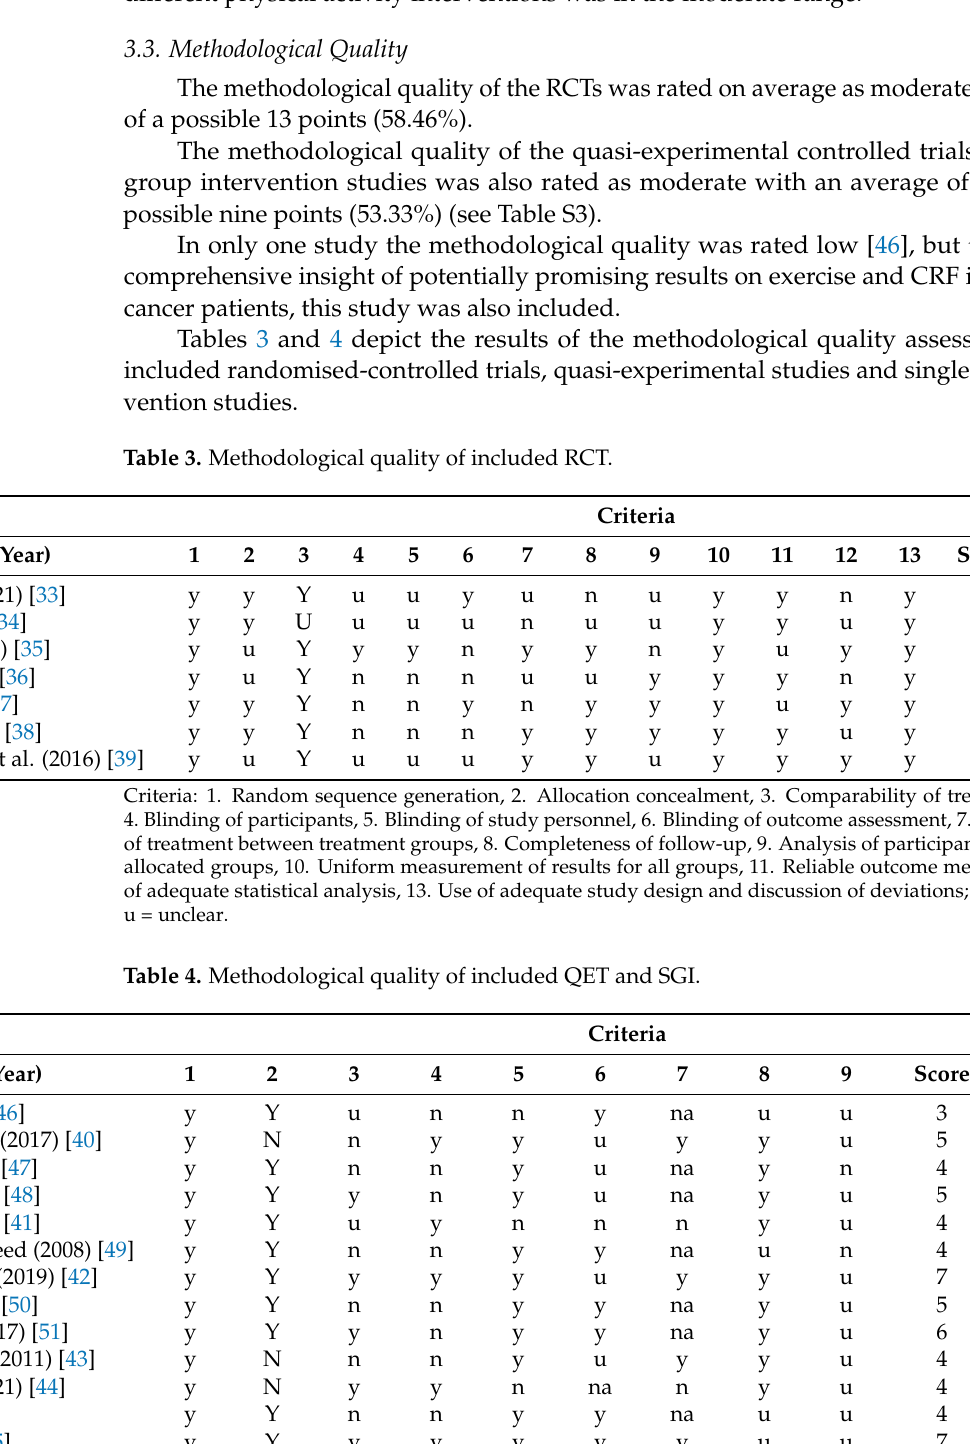
Criteria: 1. Clearness about cause and effect, 2. Comparability of study participants, 3. Comparability of treatment between participants, 4. Availability of a control group, 5. Multiple outcome measures (pre/post-test), 6. Com- pleteness of follow-up, 7. Uniform measurement of results for all groups, 8. Reliable outcome measures, 9. Use of adequate statistical analysis; y = yes; n = no; u = unclear; na = not